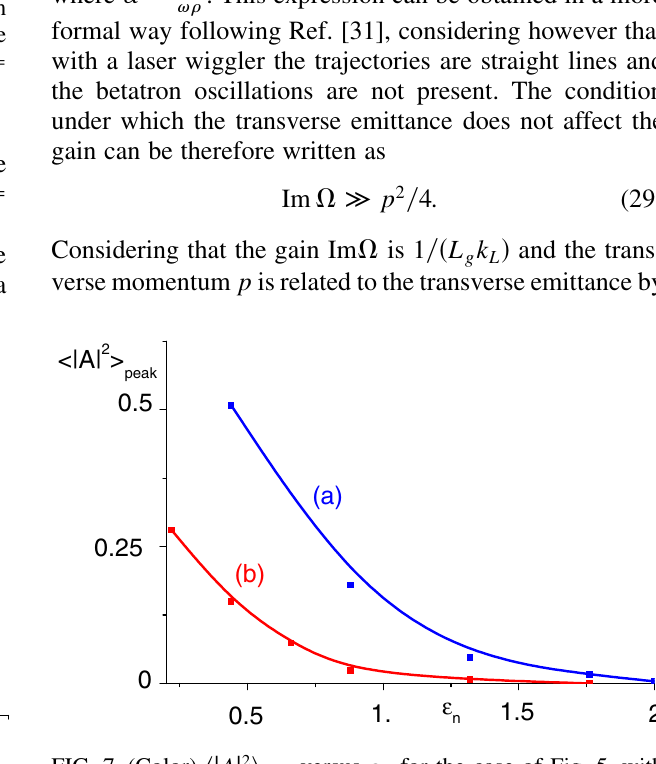
(cid:4) 0 : 8 (cid:11) m , (cid:2) a (cid:4) L L 0 (cid:4) 0 : 88 (cid:11) m n